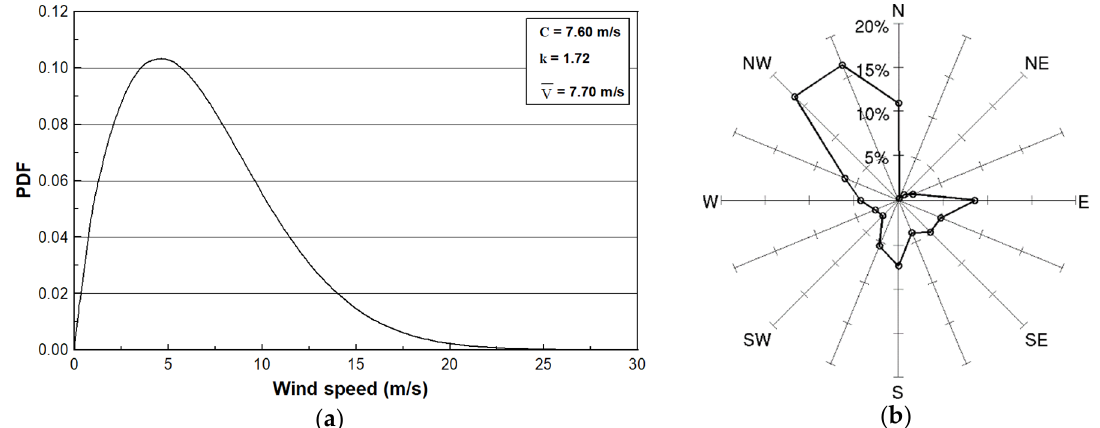
Figure 5. Configuration of ( a ) Weibull distribution and ( b ) wind speed (at 94-m height) of the Daejeong offshore site.